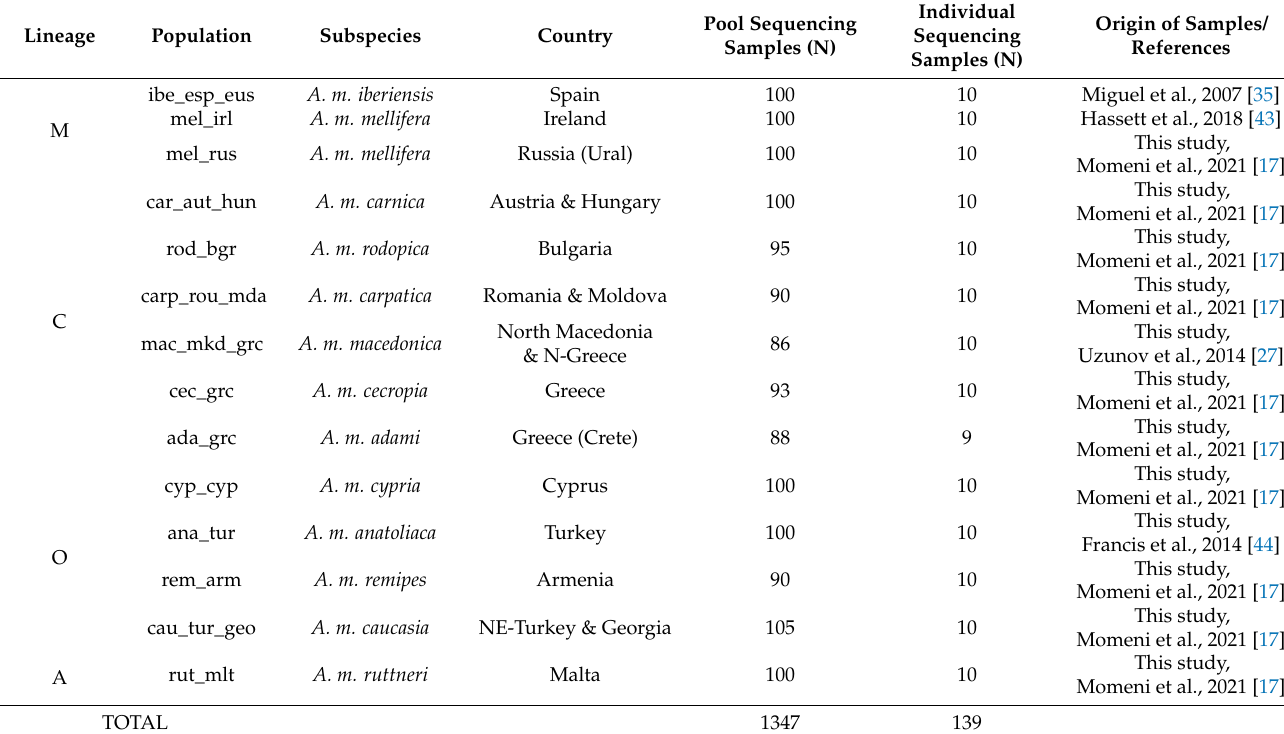
Table 1. Sample sizes and origin of the 14 populations used in this